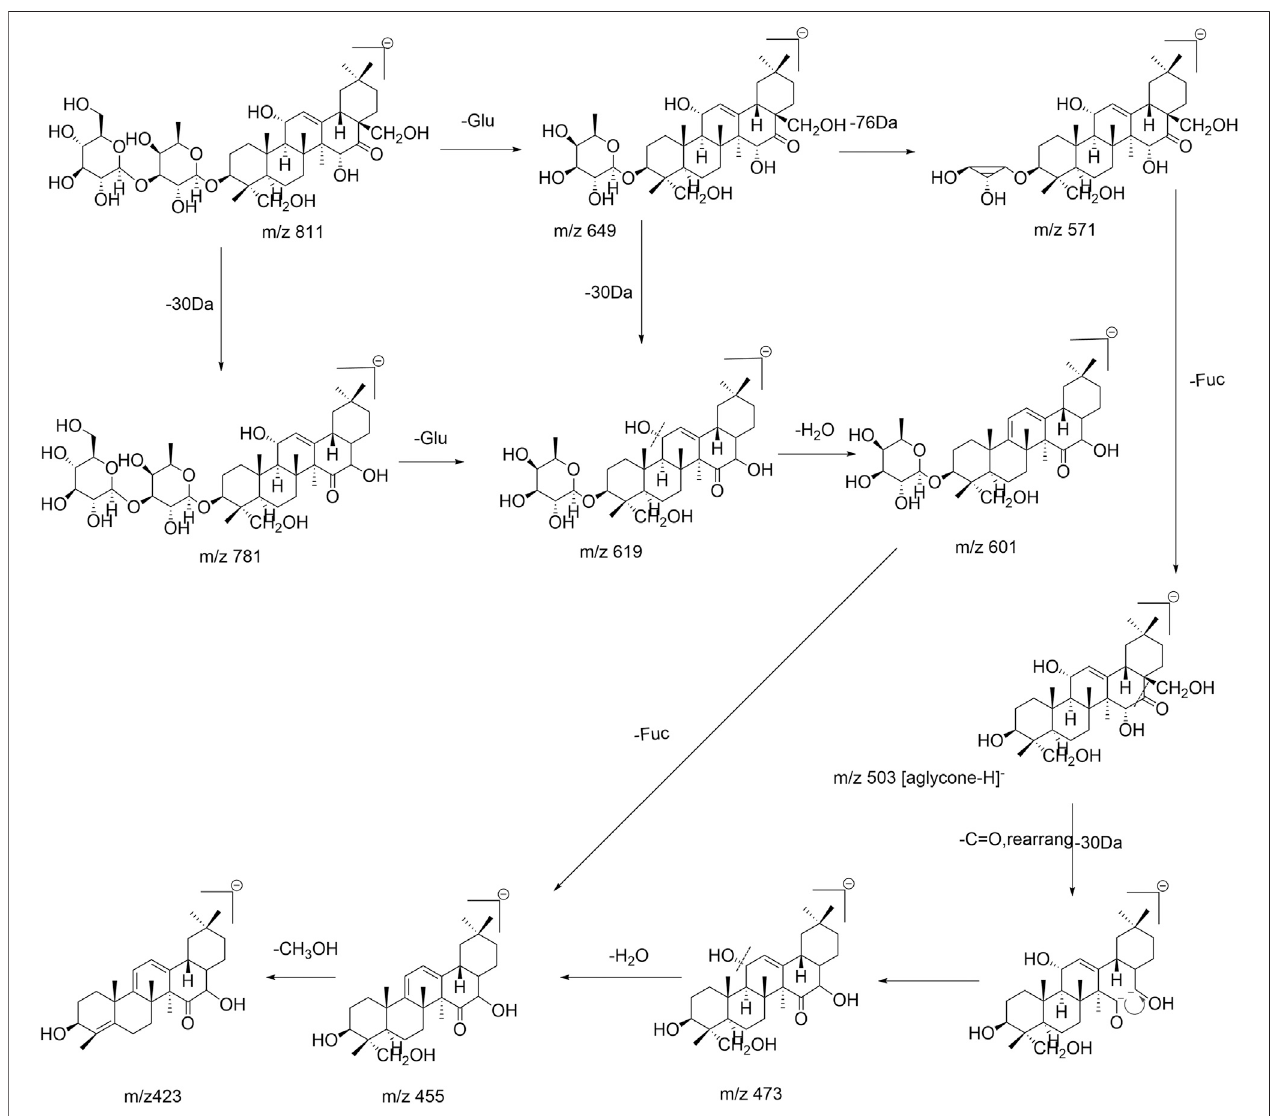
FIGURE 5 | Fragmentation pathway of Tibesaikosaponin